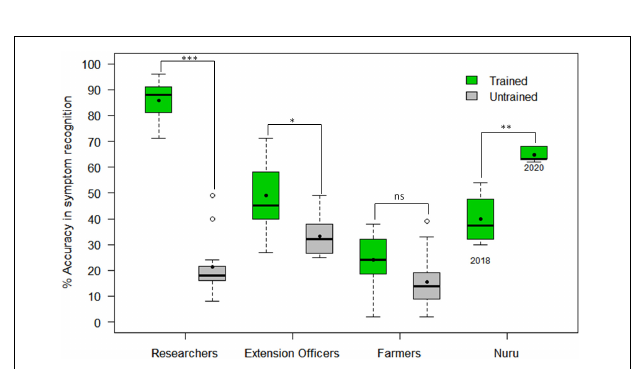
FIGURE 3 | Comparison of accuracy in recognizing symptoms of CMD, CBSD and CGM damage by PlantVillage Nuru, researchers, agricultural extension officers and farmers who have and those who have not previously received training on cassava diseases and pests ( n = 22 for each paired comparison). The black line within the boxes represents the median, the top and bottom of the box represent the 75th and the 25th percentiles, the whiskers represent the maximum and minimum values while the symbols ( and ( (cid:13) ) represent the mean and the